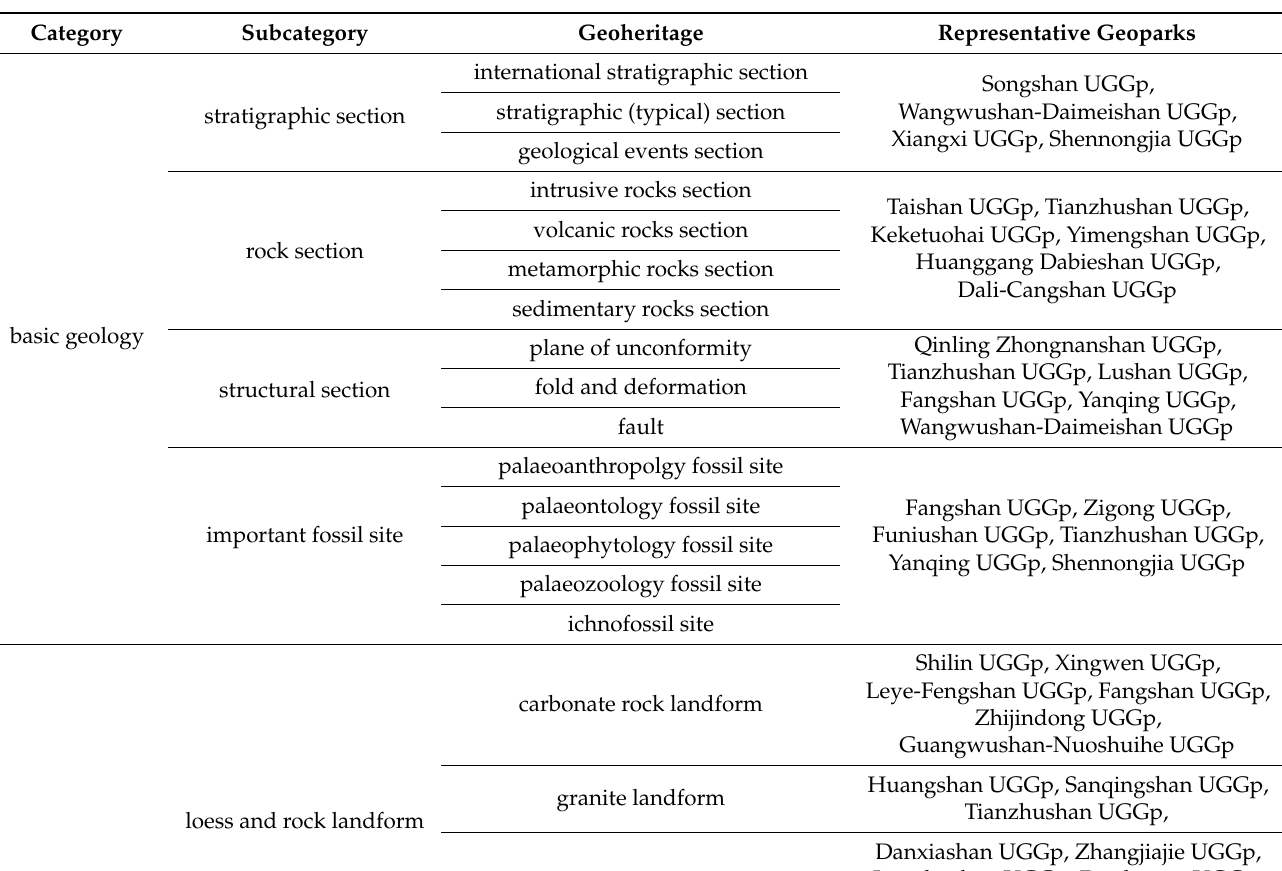
Table 1. The classification of geoheritage in China in